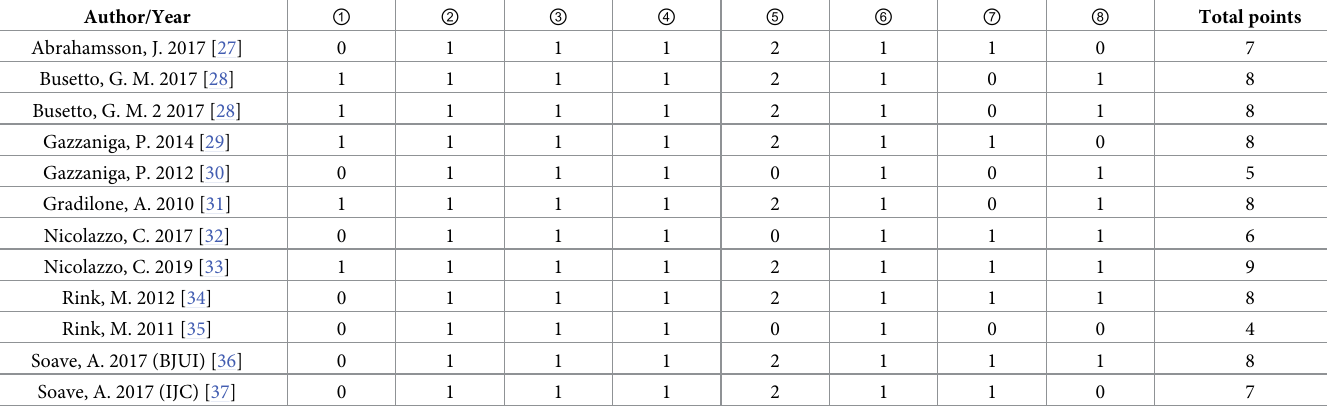
Table 2. Quality assessment of the included studies according to the Newcastle-Ottawa scale.